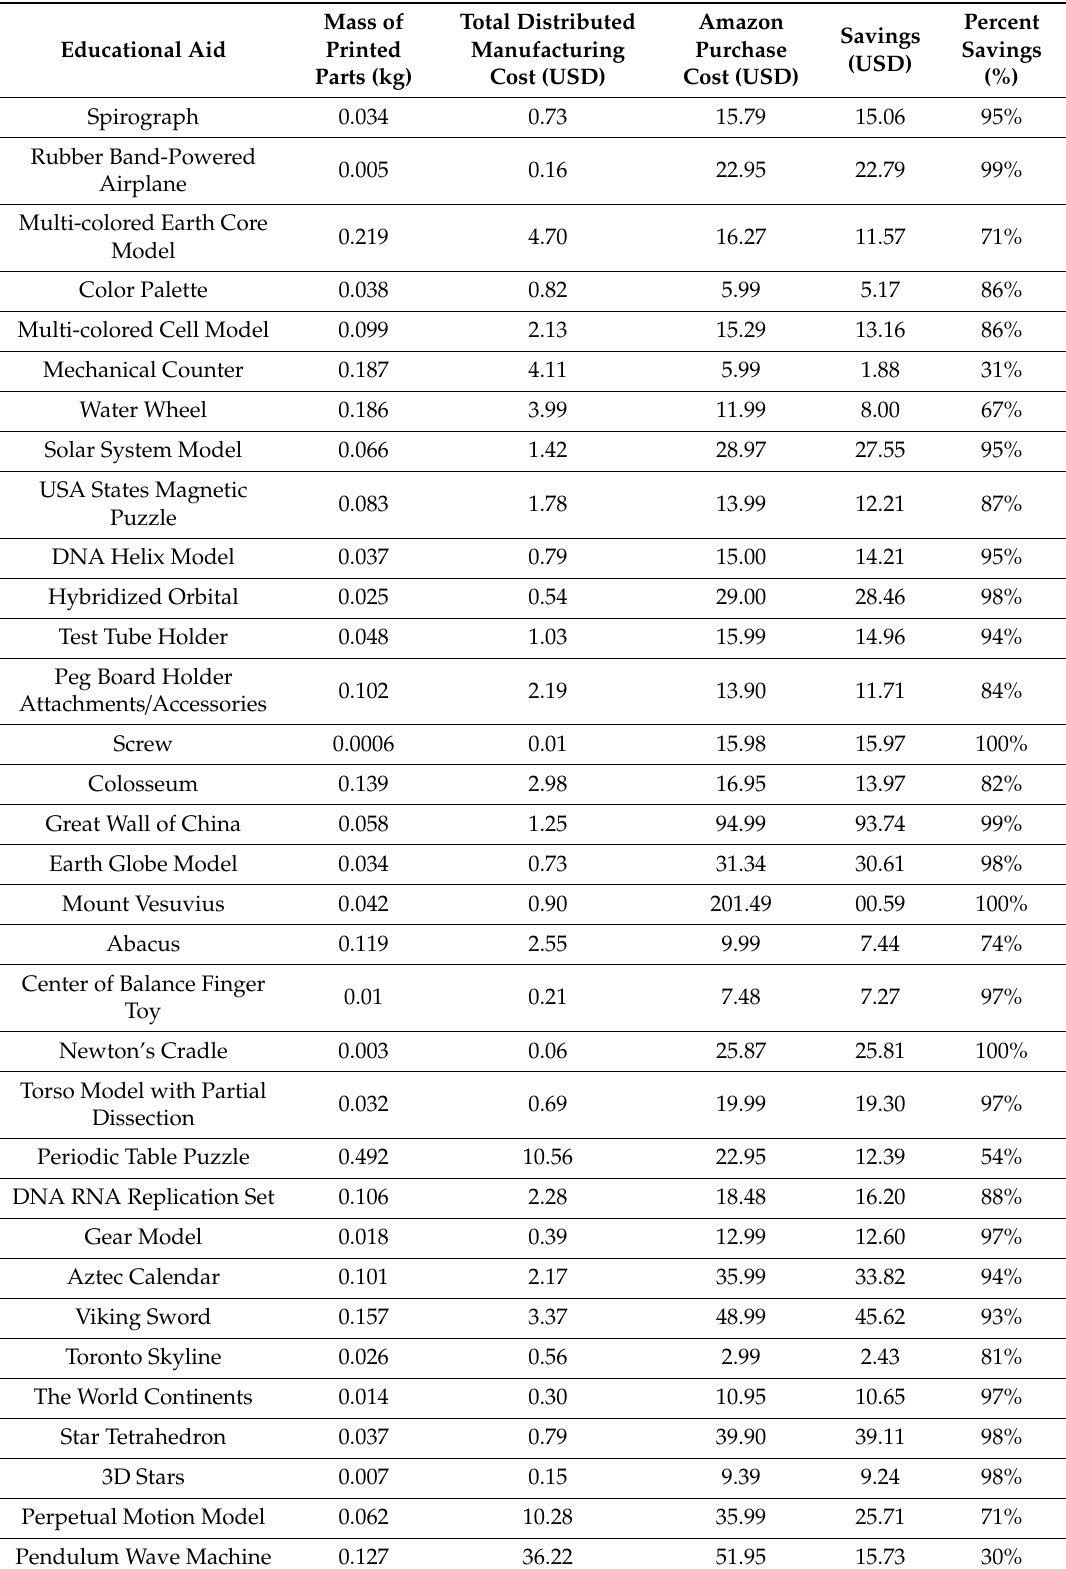
Table 3. Evaluated educational aids based on estimated printed mass and economic comparison including savings and percent savings compared to Amazon